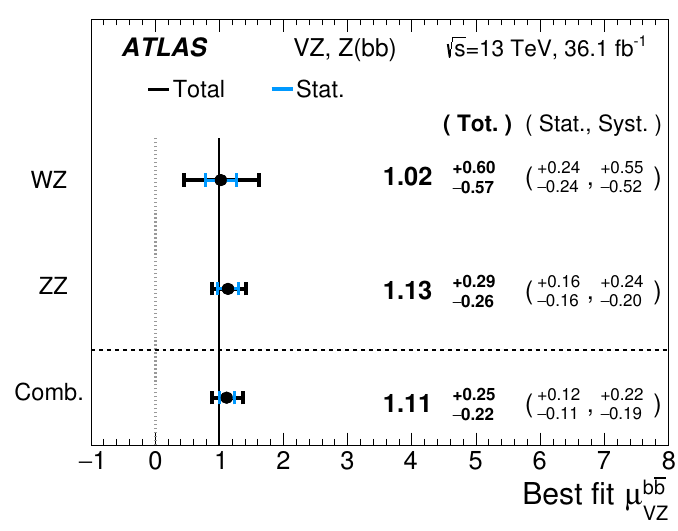
Figure 9 . The (cid:12)tted values of the V Z signal strength parameter (cid:22) V Z for the WZ and ZZ processes and their combination. The individual (cid:22) V Z values for the ( W=Z ) Z processes are obtained from a simultaneous (cid:12)t with the signal strength parameters for each of the WZ and ZZ processes (cid:13)oating independently. The compatibility of the individual signal strengths is